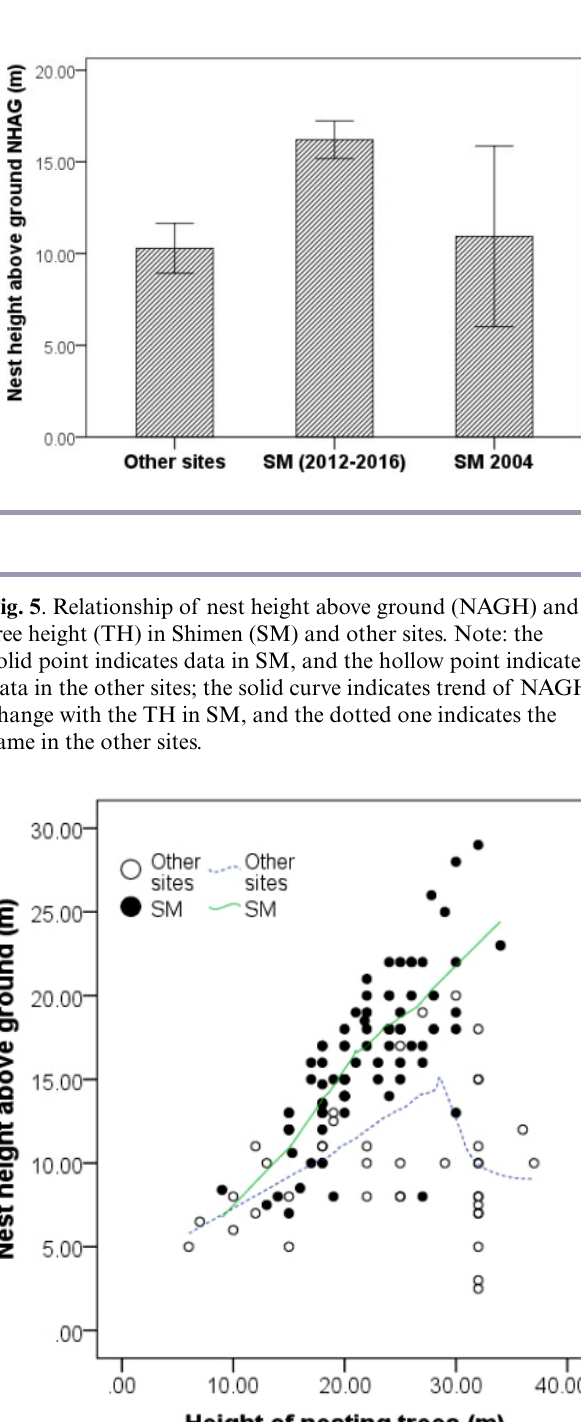
Fig. 4 . Comparison of nest height above ground in Shimen (SM) and other sites since 2012, and SM 2004 (mean value ± standard error).